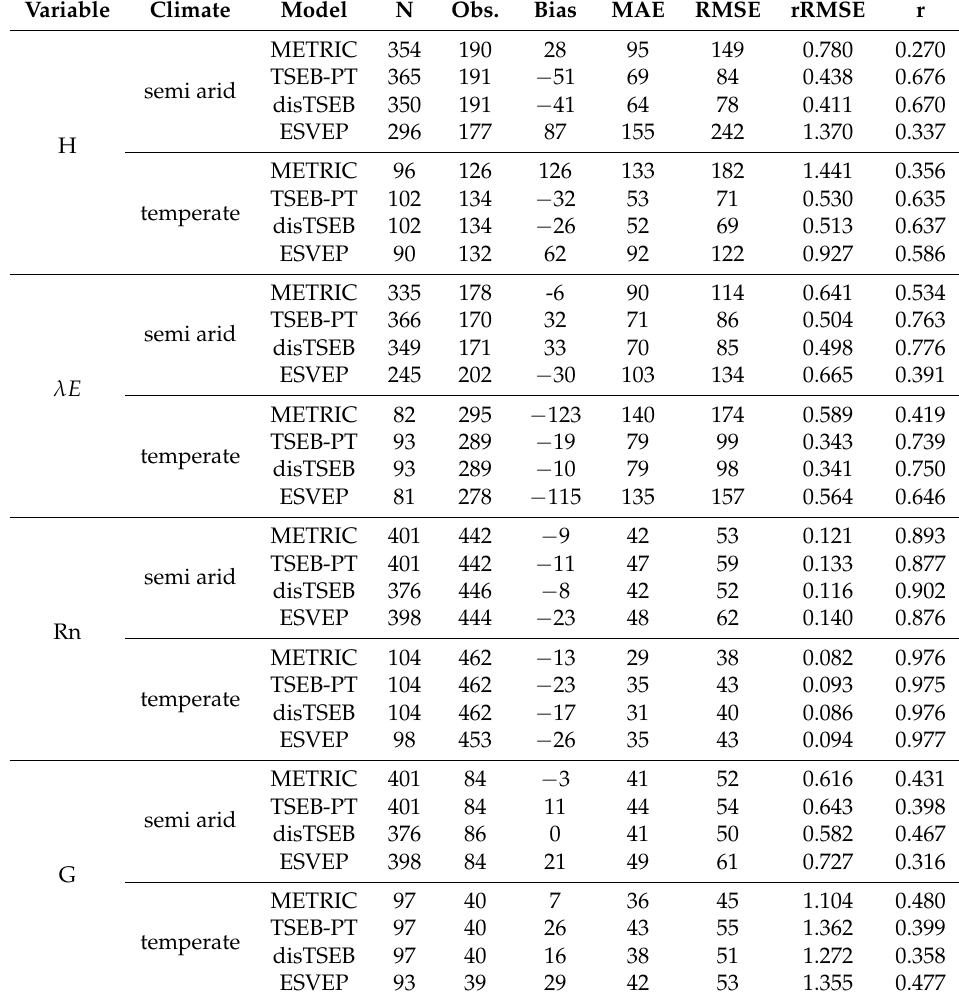
Table 7. Climate dependence of errors for METRIC, TSEB and ESVEP modelled fluxes using Decision Trees sharpened temperatures. N, number of valid cases; Obs.; mean of observed values (W m − 2 ); bias, mean difference between predicted and observed (W m − 2 ); MAE, Mean Absolute Error (W m − 2 ),